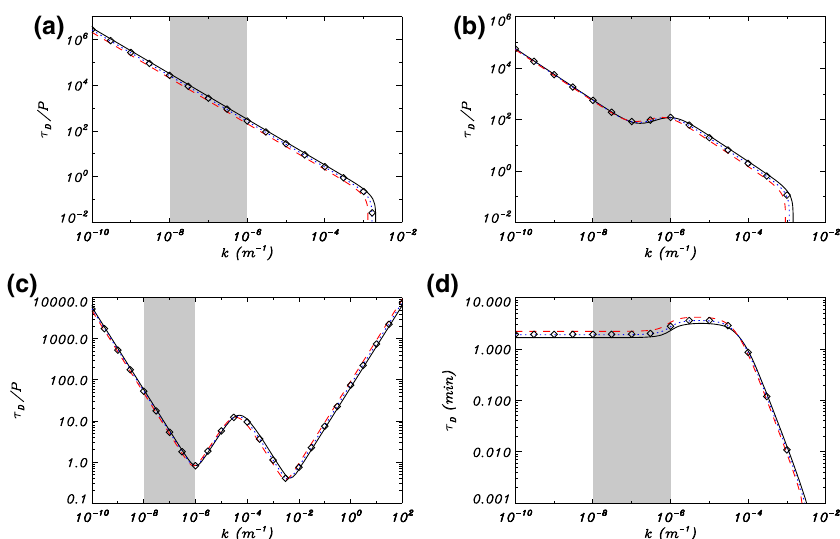
Fig. 65 Wave damping by ion-neutral effects in a uniform medium. a – c Ratio of the damping time to the period, τ d / P , versus the wavenumber, k , corresponding to the Alfvén wave, fast wave and slow wave, respectively. d Damping time, τ d , of the thermal wave versus the wavenumber, k . The different linestyles represent the following abundances: ξ HeII = 0% (solid line), ξ HeII = 10% (dotted line) and ξ HeII = 20% (dashed line). In all computations, ˜ μ H = 0 . 8 and δ He = 0 . 1. The results for ξ HeII = 10% and δ He = 0 . 5 are plotted by means of symbols for comparison. The shaded regions correspond to the range of typically observed wavelengths of prominence oscillations. In all the figures the angle between the wavevector and the magnetic field is π/ 4. Image reproduced with permission from Soler et al. (2010b), copyright by